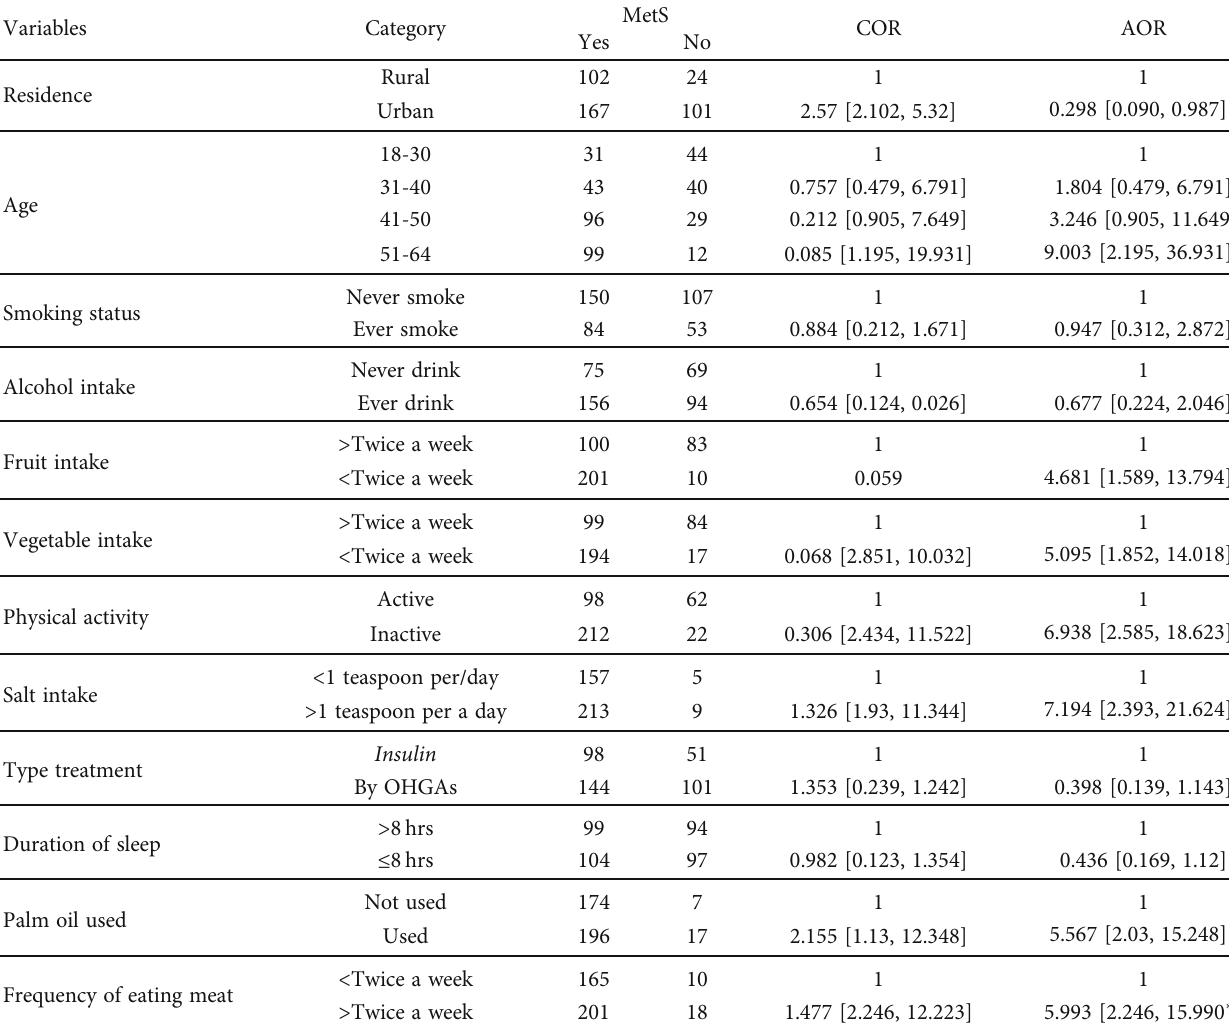
Table 2: Multivariable logistic regression analysis of factors associated with metabolic syndrome among patients with type 2 diabetics at hospitals in Southwest